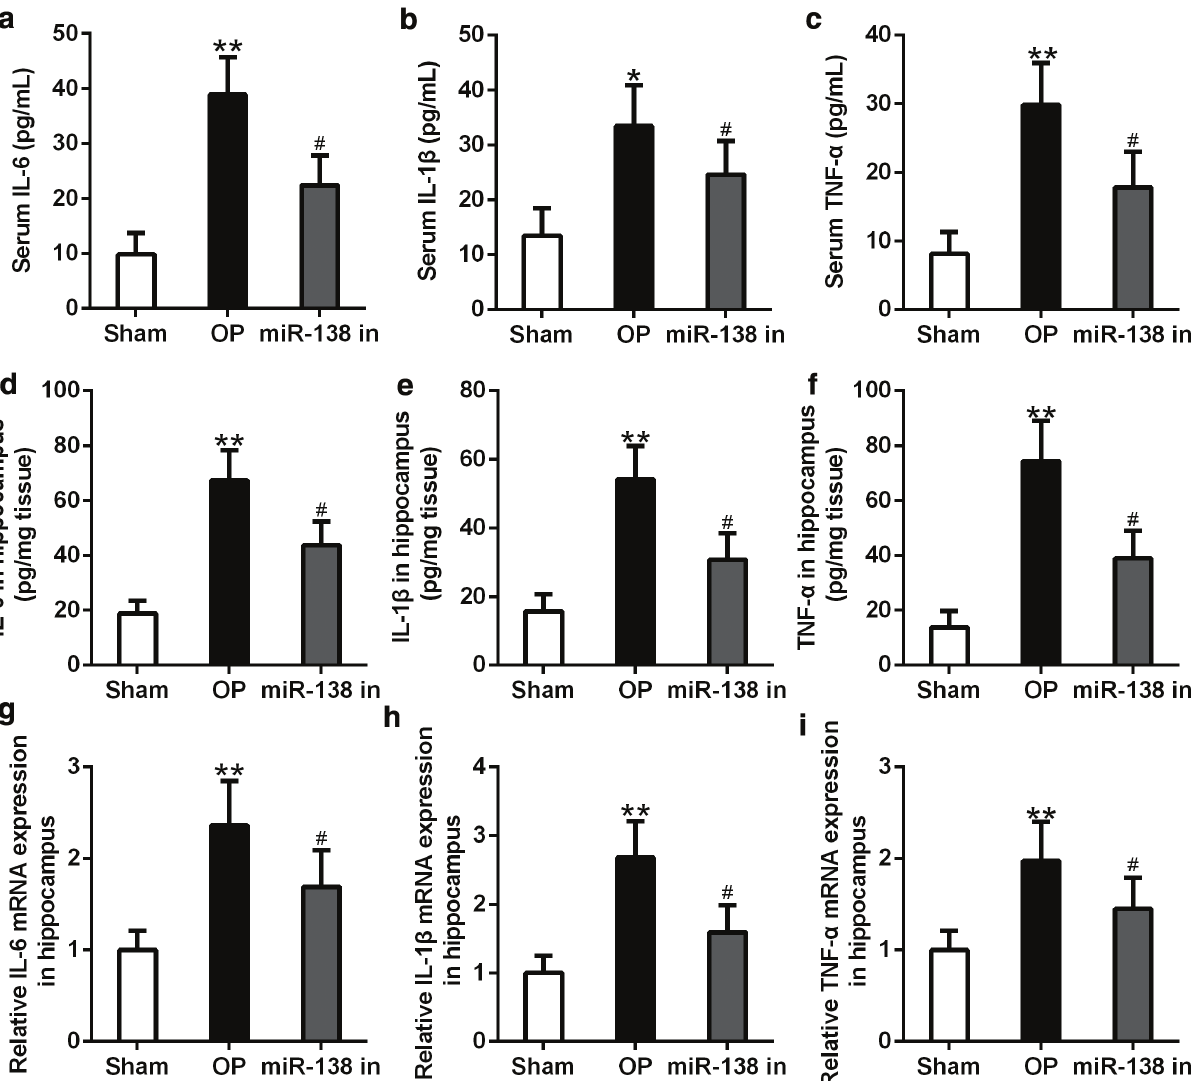
Fig. 4. Inhibition of miR-138-5p reduced systemic inflammatory in cardiac surgery induced postoperative cognitive dysfunc- tion (POCD) mice 24 h after surgery. ELISA was used to analyze the levels of IL-6 (a), IL-1 β (b) and TNF- α (c) in serum from indicated mice. ELISA was used to analyze the levels of IL-6 (d), IL-1 β (e) and TNF- α (f) in hippocampus from indicated mice. qRT-PCR was used to analyzed the mRNA levels of IL-6 (g), IL-1 β (h) and TNF- α (i) in hippocampus from indicated mice. Sham: C57BL/6 wild-type mice with sham cardiac surgery; OP: C57BL/6 wild-type mice with cardiac surgery. miR-138 in: C57BL/6 wild-type mice with cardiac surgery treated with miR-138-5p inhibitors. Data were presented as ± SD. * P < 0.05, **